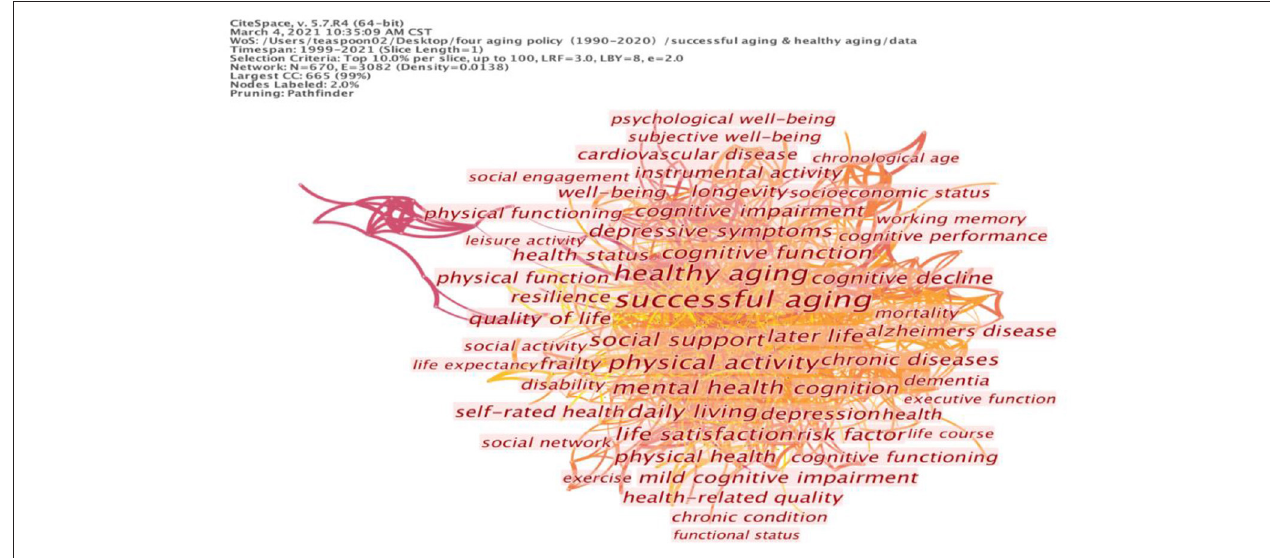
FIGURE 2 | Cluster map of keywords on successful aging and healthy aging.